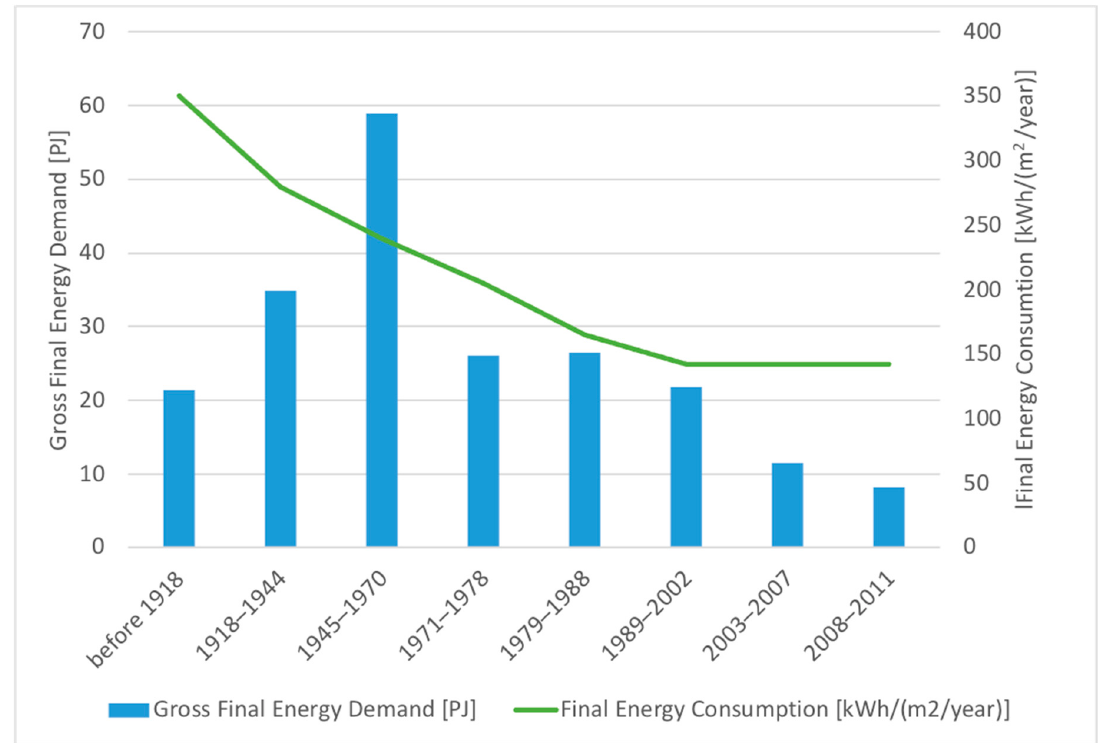
Figure 2. The relation between age and energy demand of SFH (rural) in Poland.